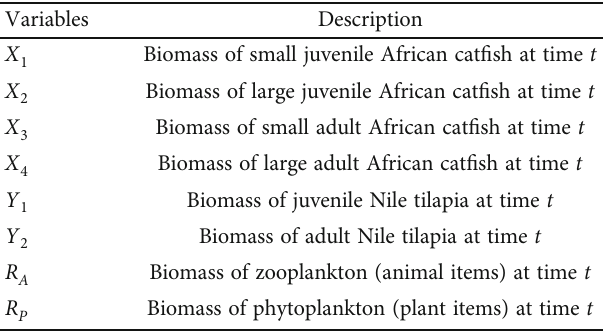
Table 1: Variables used in the stage-structured model for African cat fi sh, Nile tilapia, and the two food resources.